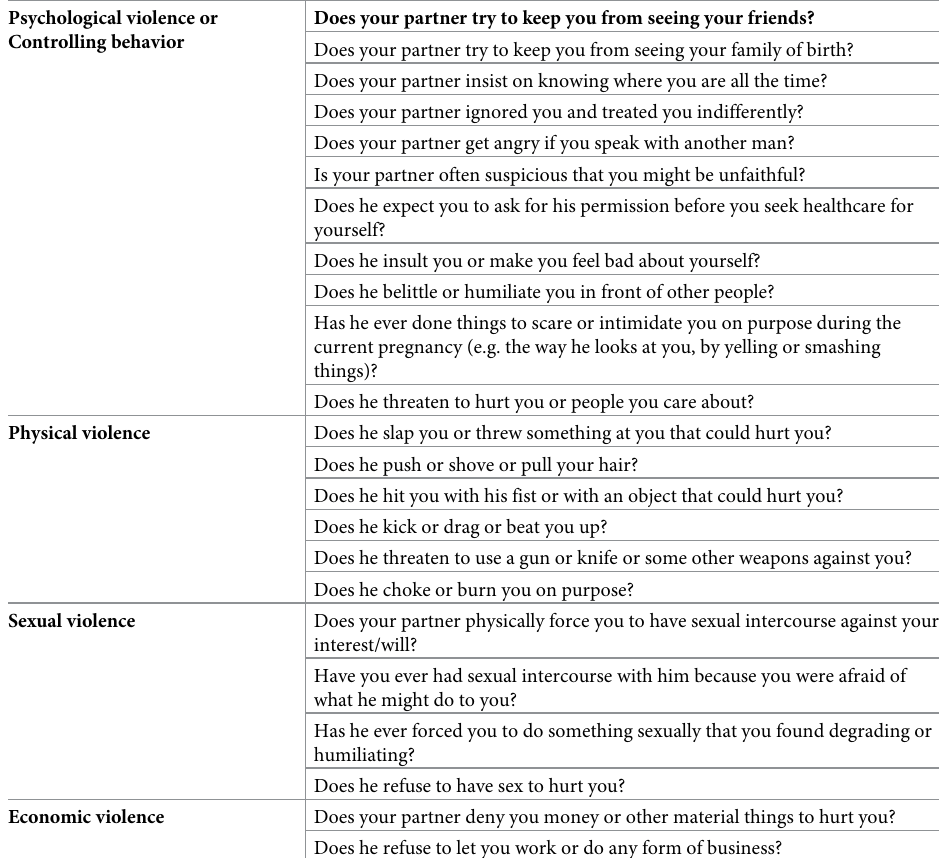
Table 1. A series of questions asked to confirm various forms of IPV among pregnant women in the rural